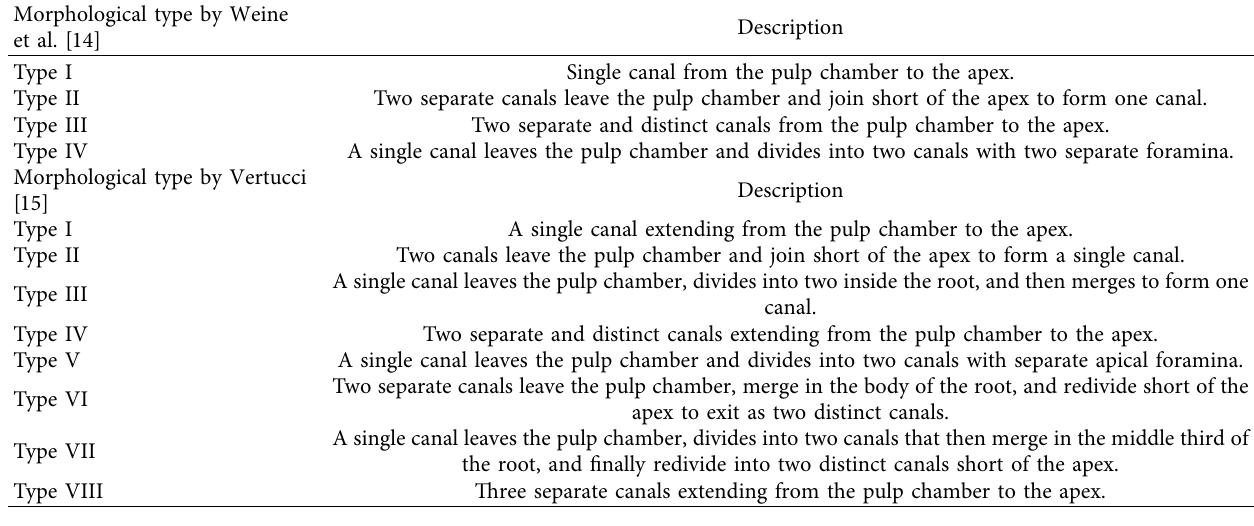
Table 2: Classification of the root canal system proposed by Weine et al. [14] and Vertucci [15]. Morphological type by Weine